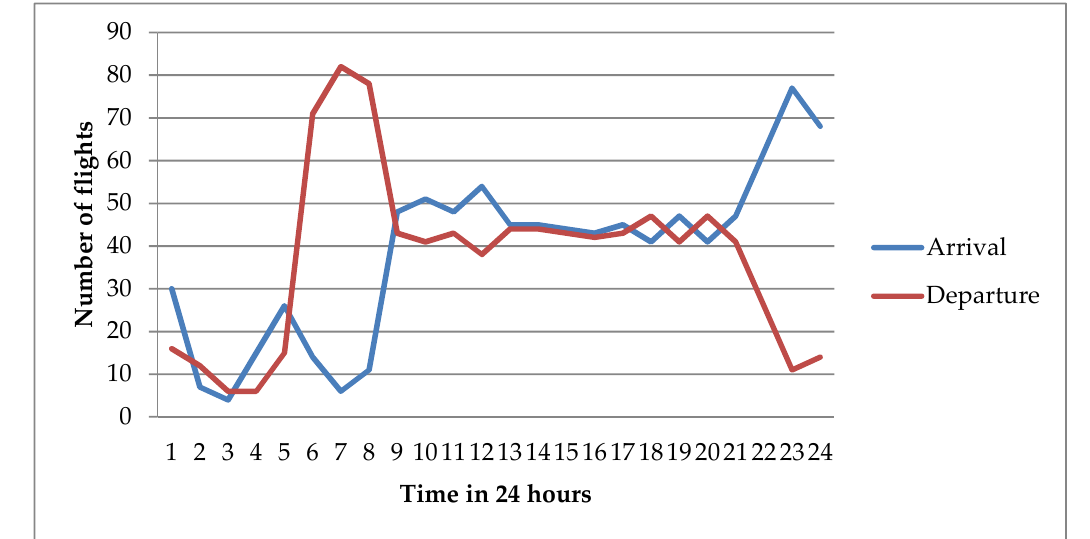
Figure 1. The typical slot structure of PEK airport from July to September in 2017.